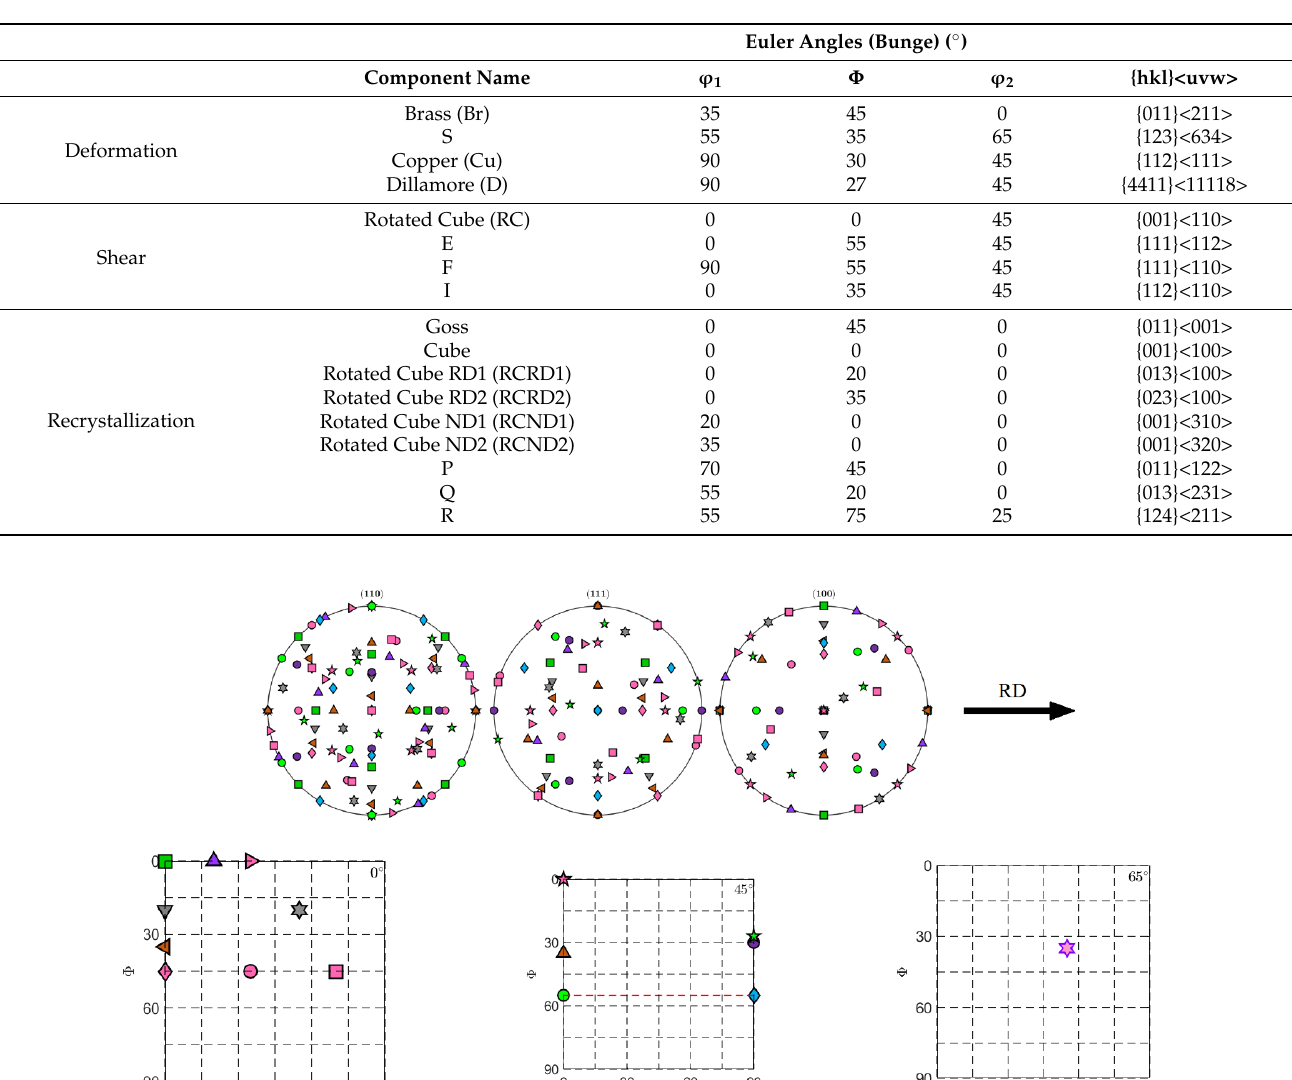
Table 7. Ideal texture components for FCC metals.